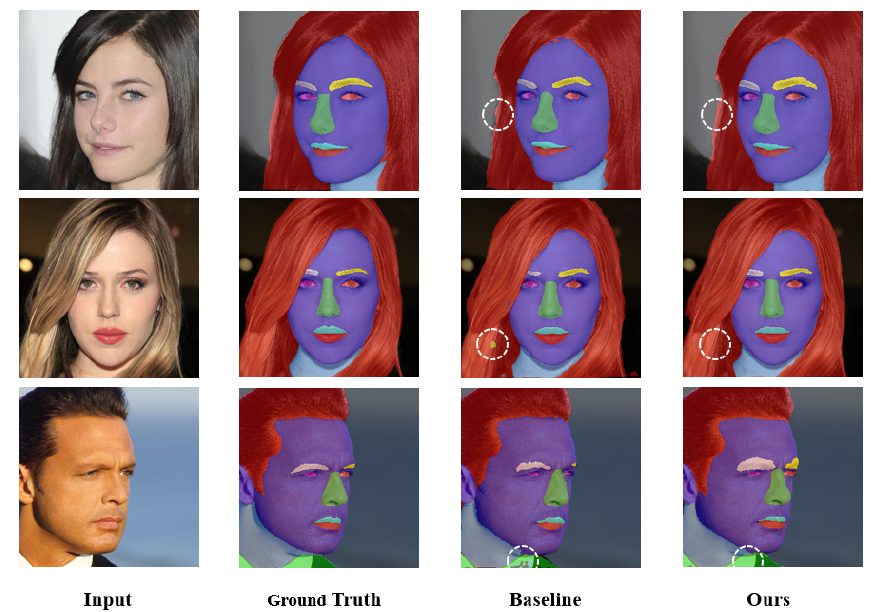
Figure 7. Face parsing results comparison against FPN-ResNet18 [8] baseline, where significantly improved regions are marked with white dashed boxes. To highlight the details, we merge the input and output color maps according to 1:1. Our method performs better on both boundary details and fine-grained segmentation.